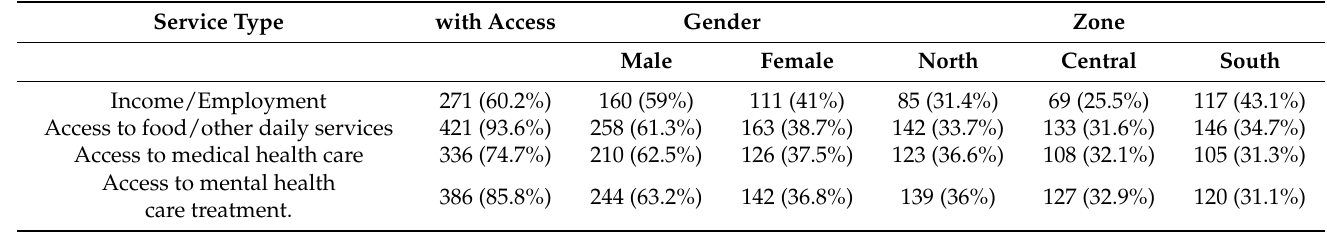
Table 2. Subgroups of service accessibility by gender and geographical